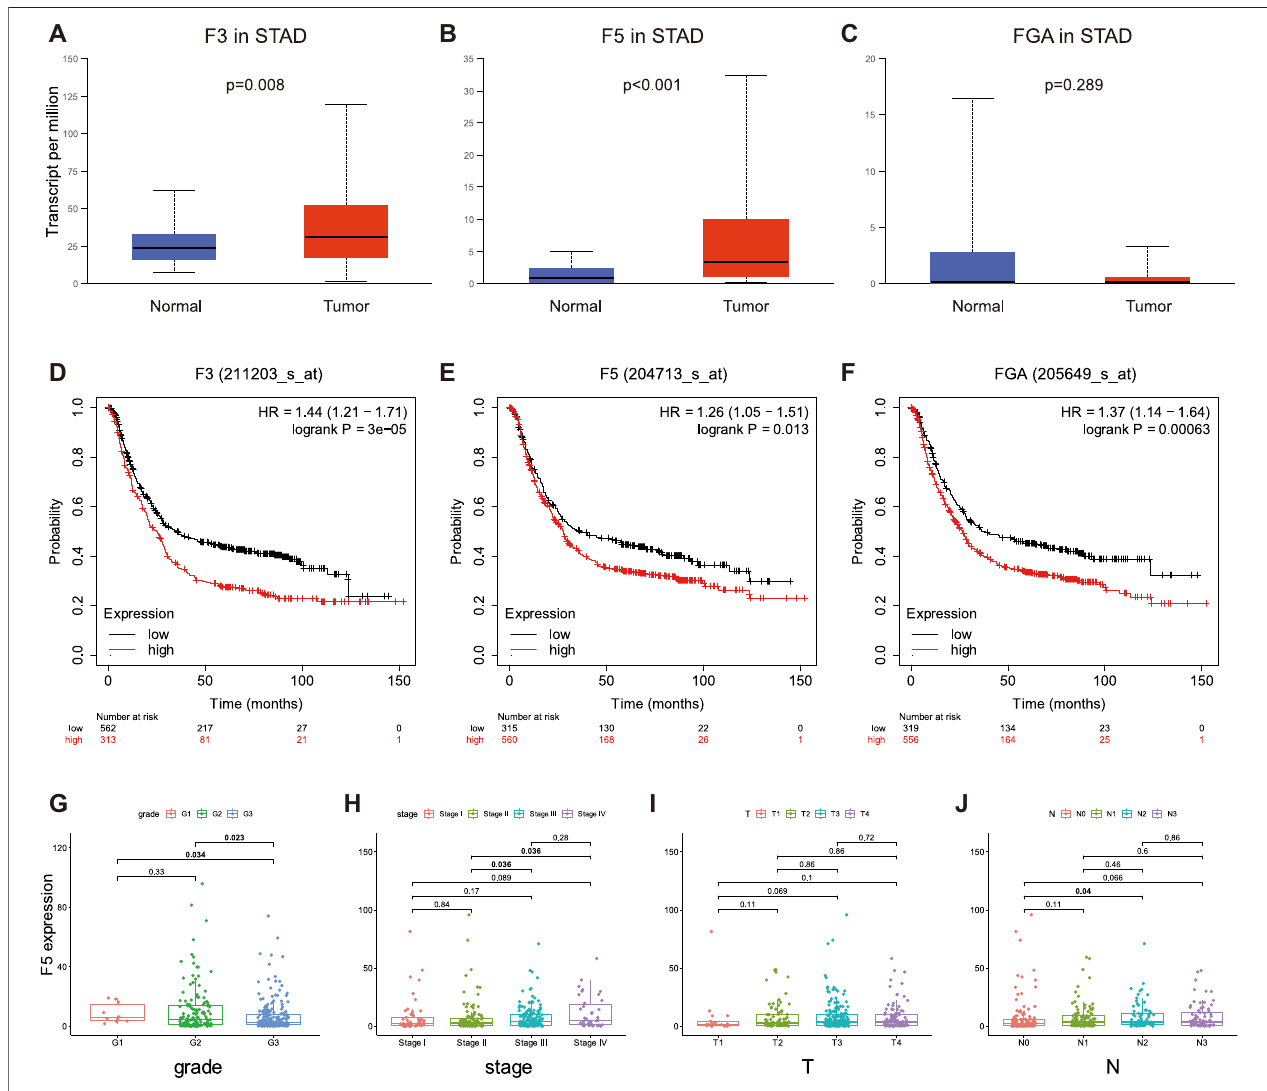
FIGURE 5 | Survival correlation, differential expression and clinicopathological relations in D-dimer-related genes. (A – C) Expression levels of F3, F5 and FGA between GC and normal samples using UALCAN. (D – F) Kaplan-Meier plots of the three D-dimer-related genes in GC using KM plotter. (G – J) Relationship between F5 expression and clinicopathological